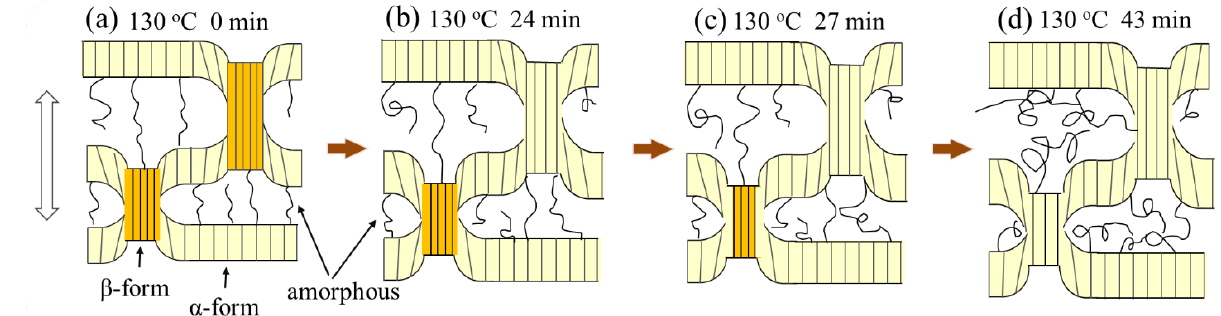
Figure 11. The model illustrates the higher-order structural evolution of the preoriented PHBV film during annealing. The vertical arrow indicates the oriented direction.